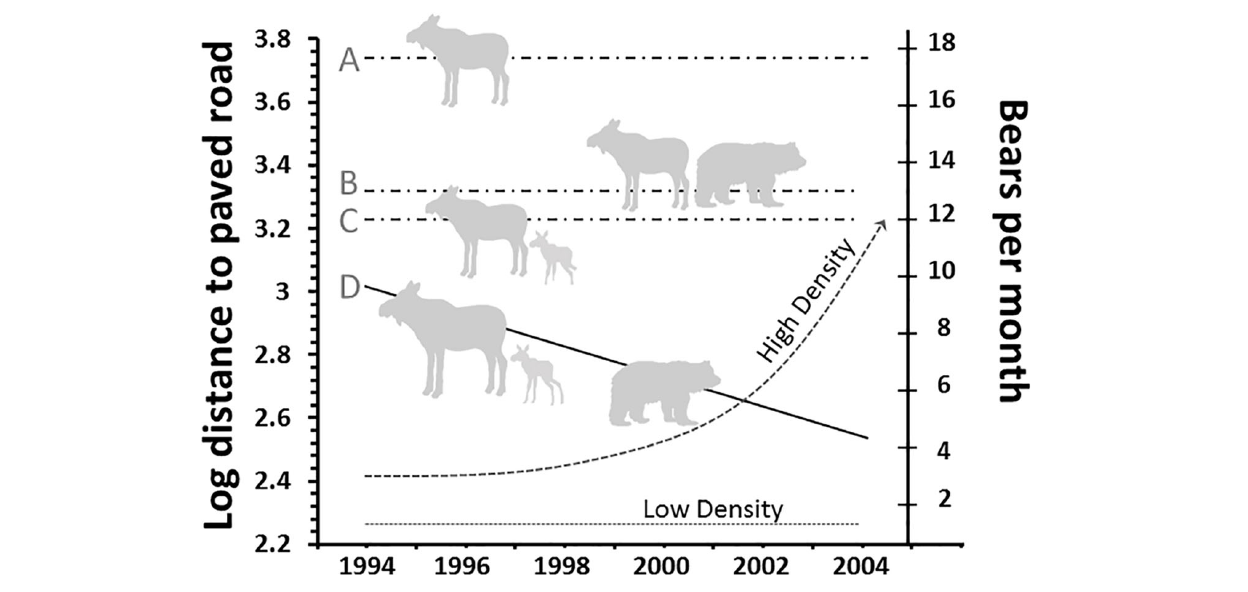
FIGURE 4 | Mean distance (10 2 m) of female moose of different reproductive status to roads during the spring parturition season. Non-pregnant females (A) in areas lacking and (B) with grizzly bears on days of median birth for conspecifics and for birthdates where bears were lacking (C) and present (D) . Modified from Berger